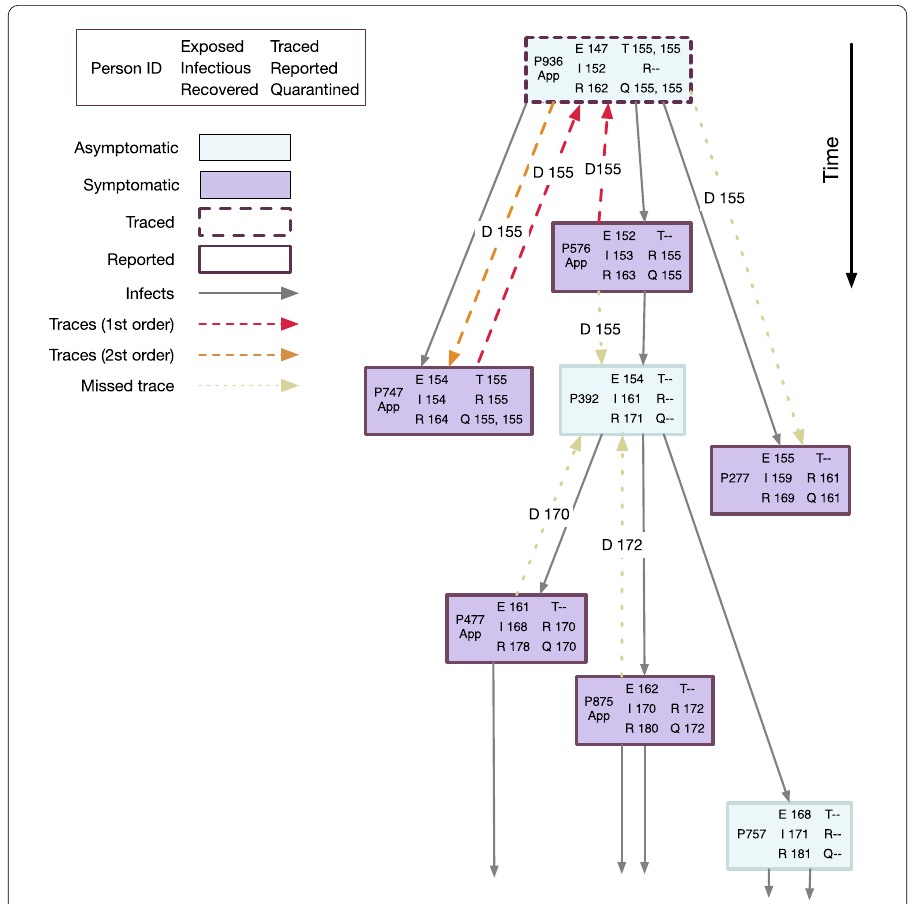
Figure 5 Spread and containment of SARS-CoV-2 using tracing and quarantine interventions in a Monte Carlo simulation including 1st and 2nd order tracing. The downward arrow indicates the time axis. Shown is a small sub-tree of the full infection tree. This sub-tree starts with simulated person P936, who was exposed on day 147, and includes the infection chains for the first three generations of infectees. The input settings for the simulation were: R 0 = 2.0, (cid:6) T trace = 7 days, p app = 0.6, η DCT = 0.9, α = 0.6. Each box represents a person. The leftmost column in each box gives the person ID and whether or not they use the DCT app. The middle column indicates the days when the person was exposed, became infectious, and recovered. The rightmost column indicates if and when the person was traced, reported, and